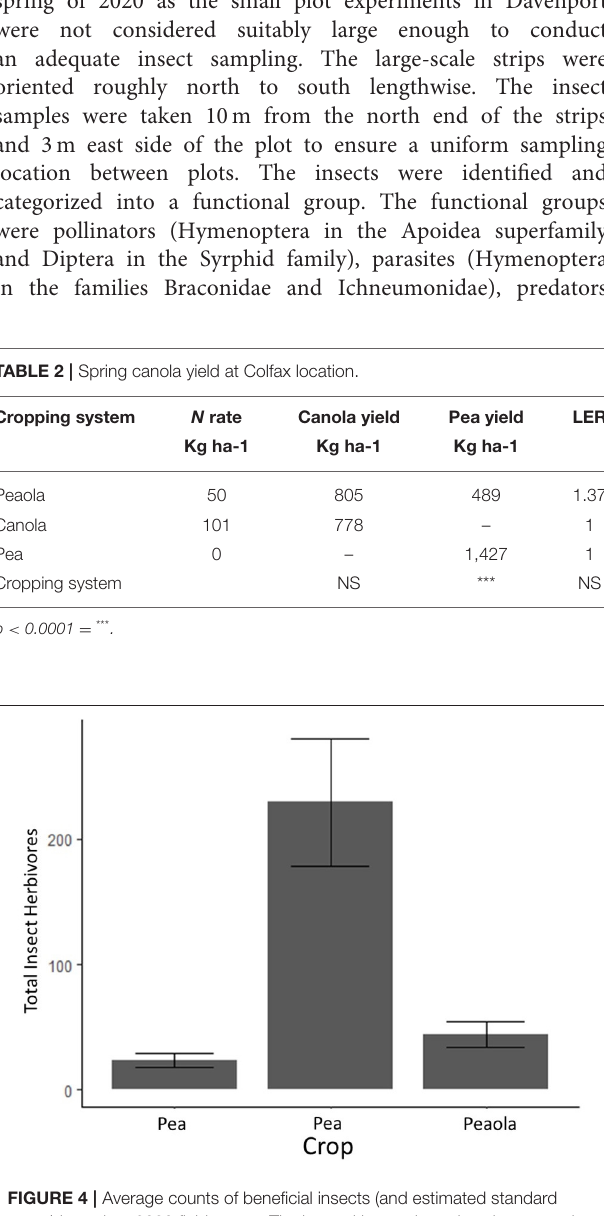
FIGURE 5 | Average counts of insect herbivores (and estimated standard errors) based on 2020 field survey. The bars with error bars that do not overlap are significantly different. Output estimates from negative binomial generalized linear mixed